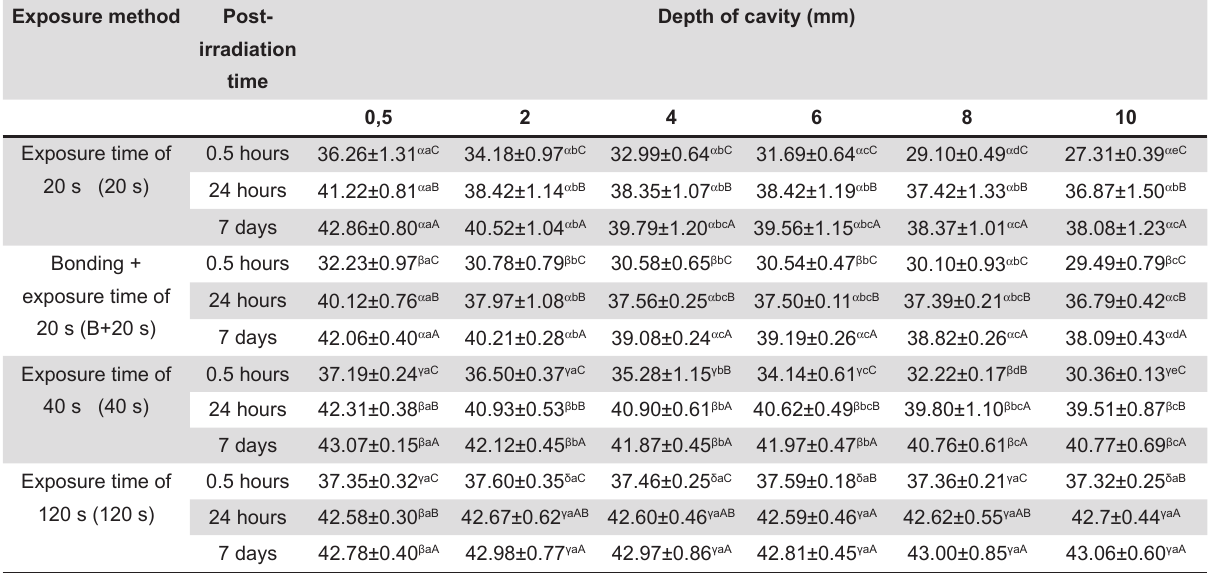
Table 2- Mean KHN±SD for KHN for Unifil Core EM (UCE) at 6 depths of cavity after 3 post-irradiation times by 4 light- exposure methods The same lower-case superscript Greek characters indicate no statistically significant differences between exposure methods at same post-irradiation time in the same depth of cavity; the same lower-case superscript letters indicate no statistically significant differences between depths of cavity at same post-irradiation time in the same exposure method; the same upper-case superscript letters indicate no statistically significant differences between post-irradiation times at same depth of cavity in the same exposure method